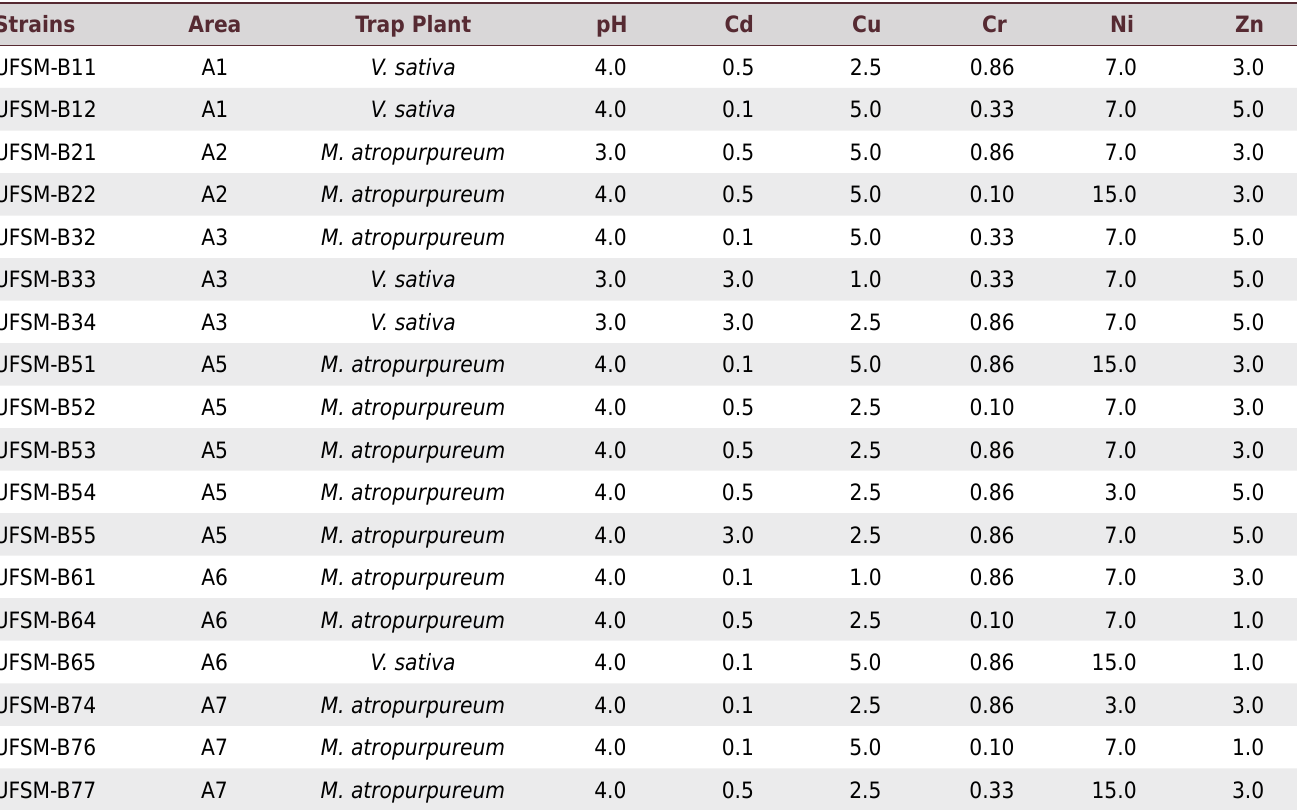
Table 3. Values of pH and heavy metal concentration tolerated (mmol L -1 ) by 18 bacterial strains selected for sequencing the 16S rRNA